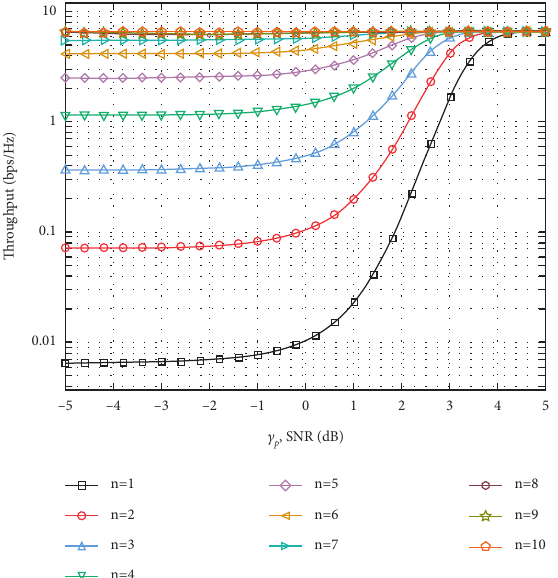
Figure 4: FD-CSS throughput versus relative the value of n in the n -out-of- N rule.